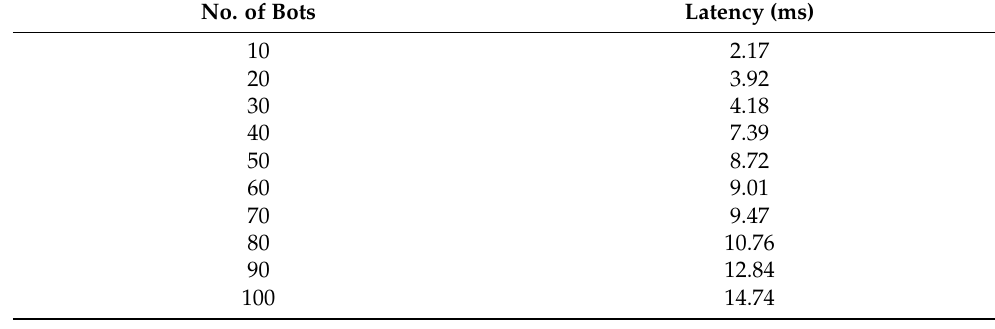
Table 2. Initial Network parameters system.